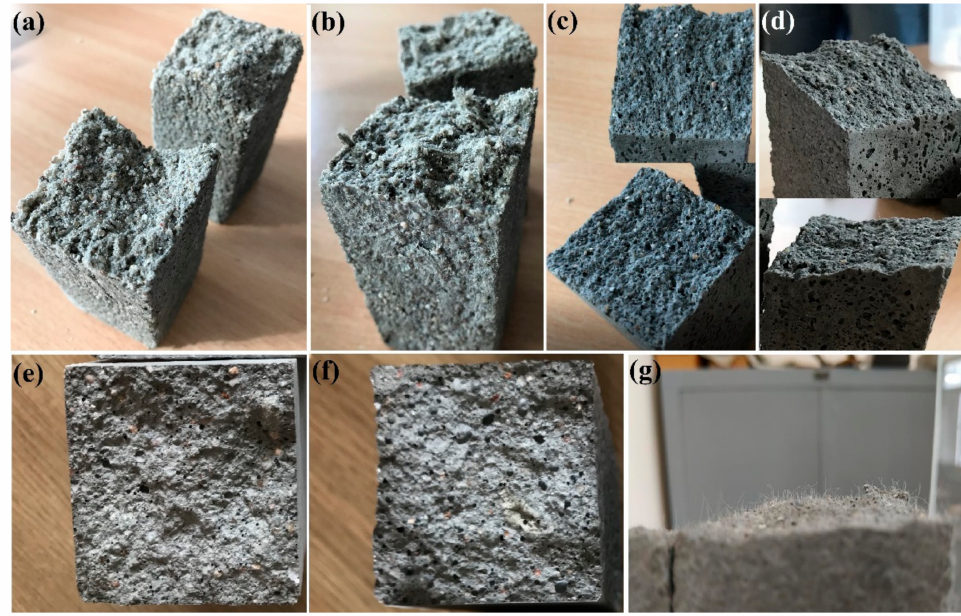
Figure 10. Damaged specimens of various series after flexural strength tests: ( a ) W1_21D, ( b ) BCF1_21D, ( c ) W2_21D, ( d ) BCF2_21D, ( e ) W3_28D, ( f ) BCF3_28D and ( g )